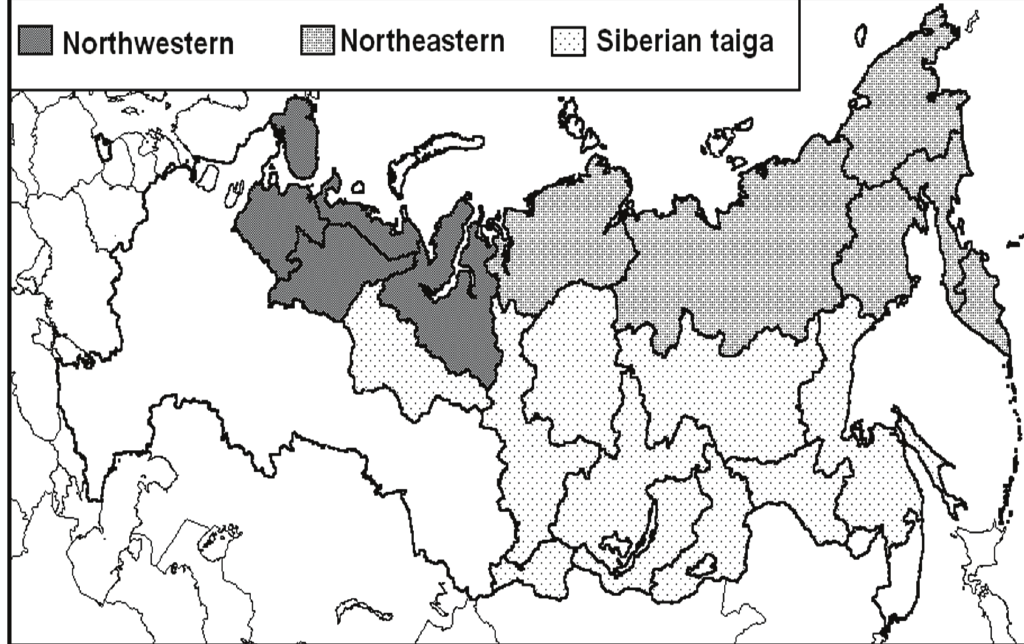
Fig. 2. Map of reindeer husbandry zones across Russia. Northwestern zone (predominantly tundra type of reindeer husbandry): Murmansk oblast’, Arkhangelsk oblast’, Nenets okrug, Komi Republic, Iamal-Nenets okrug. Northeastern zone (predominantly tundra type of reindeer husbandry): Taimyr okrug, northern districts of Sakha (Iakutiia) Republic, Chukchi okrug, Koriak okrug, Magadan oblast, Kamchatka oblast’. Siberian taiga zone (predominantly taiga type of reindeer husbandryKhanty-Mansi okrug,